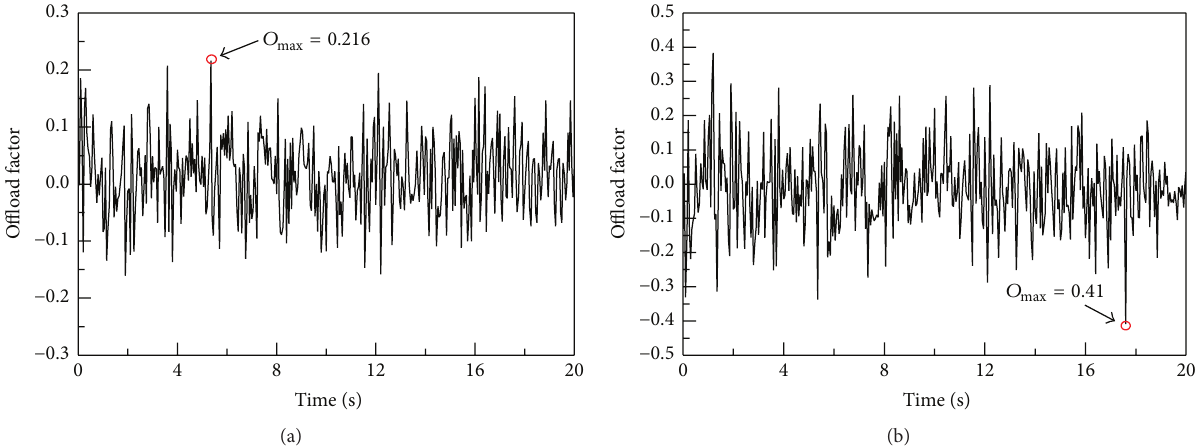
Figure 17: Offload factor time histories comparison of the first wheel set: (a) without earthquake; (b) with earthquake.